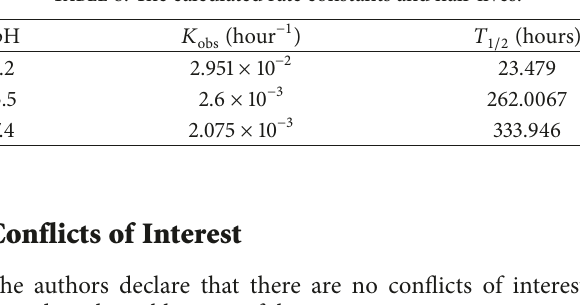
Table 8: The calculated rate constants and